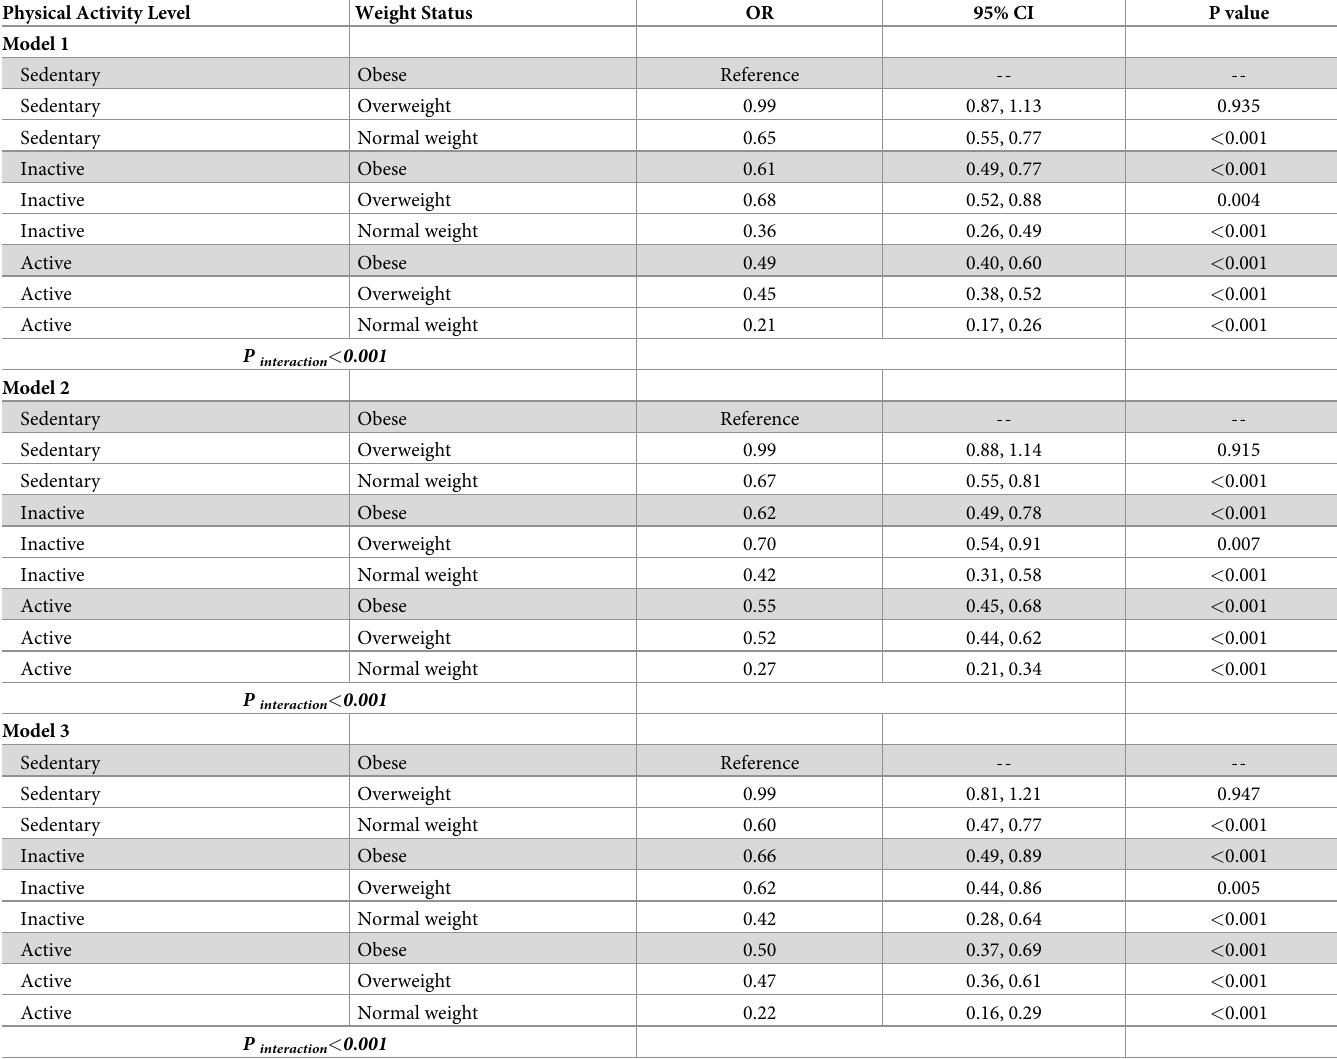
Table 4. Comparison of joint effects of physical activity level and weight status on high 10-year CVD risk among U.S adults age 30–65 years old with no history of cardiovascular disease (population-weighted, NHANES